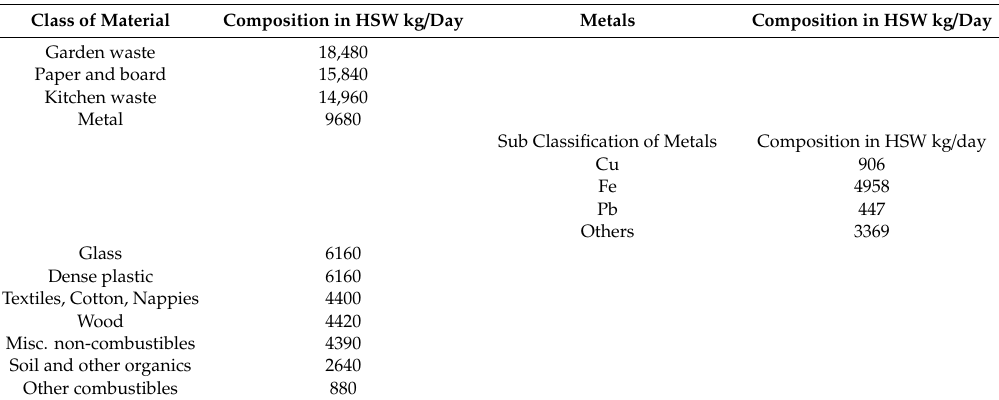
Figure 4. Classification of HSW generated in Karachi. Table 2. Classification of HSW generated in Karachi.